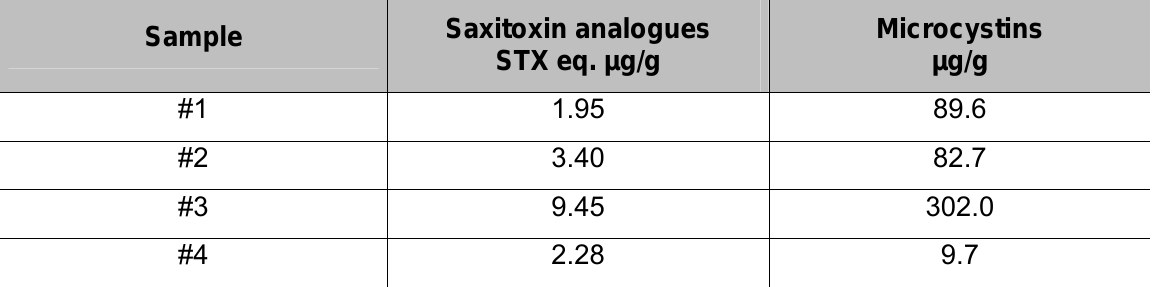
Table 2. Toxin concentrations of scum extracts from the Camamu-Almada